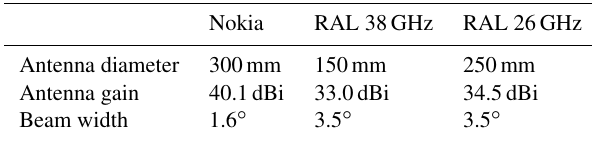
Table 1. Properties of the link antennas used in this experiment.